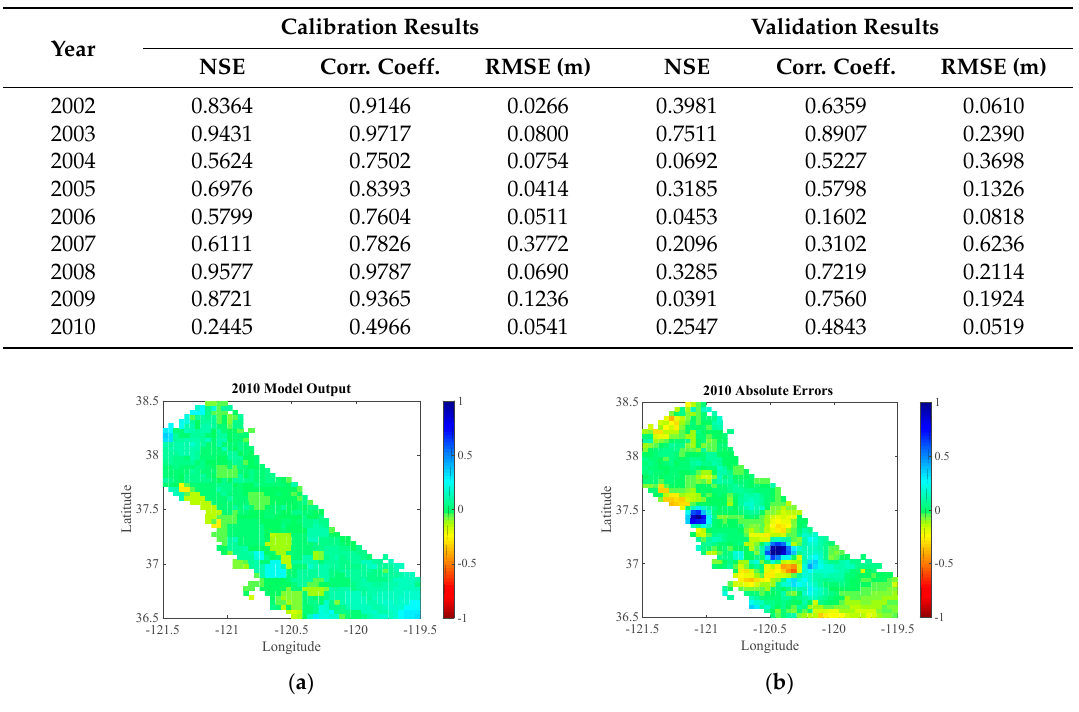
Figure 3. ( a ) Simulated groundwater storage change for 2010 (m); ( b ) Absolute errors for 2010 (m).